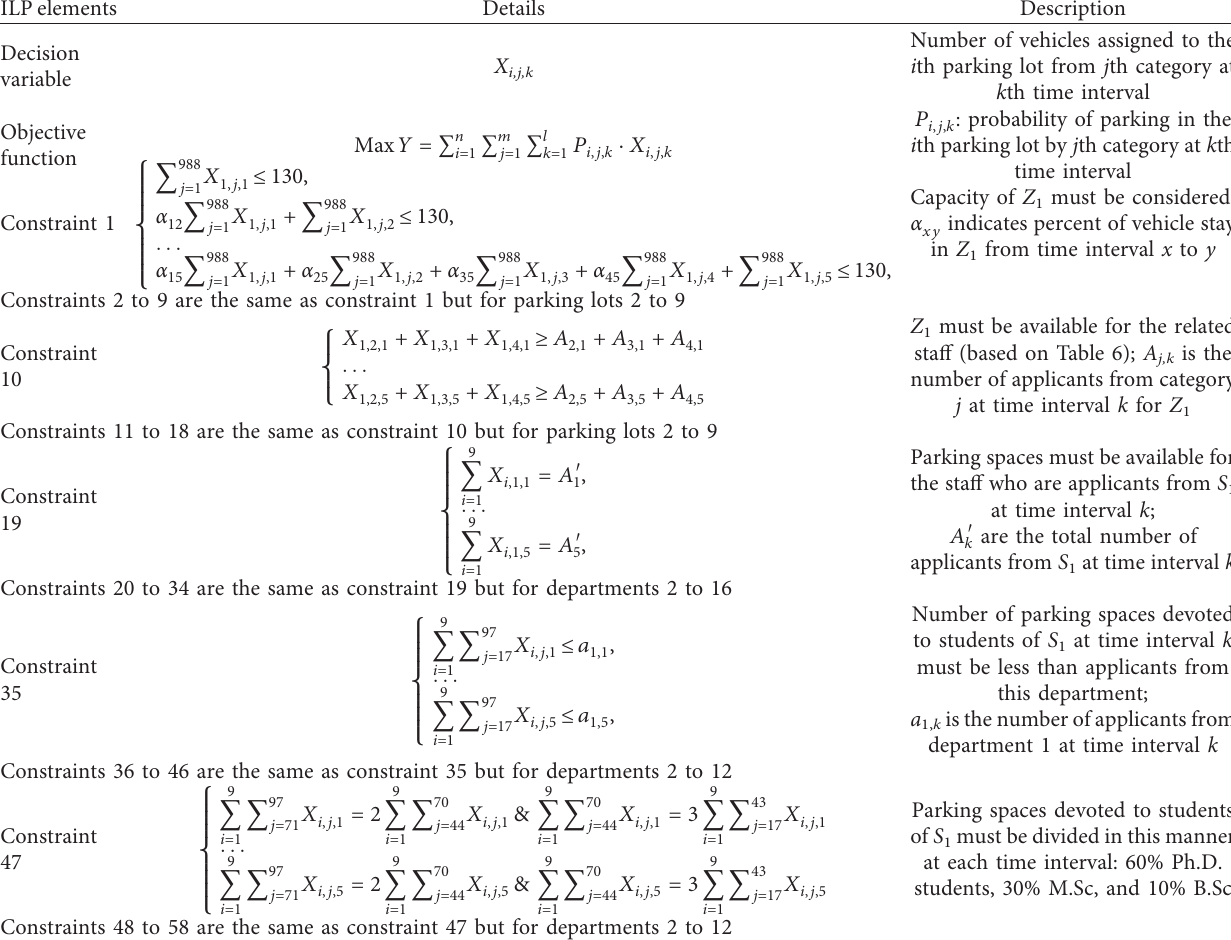
Table 9: ILP for parking optimization.